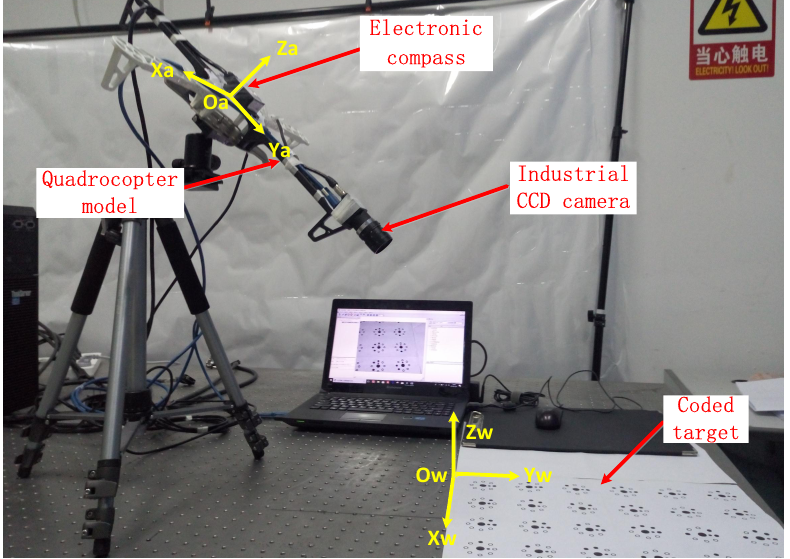
Figure 5. Experimental